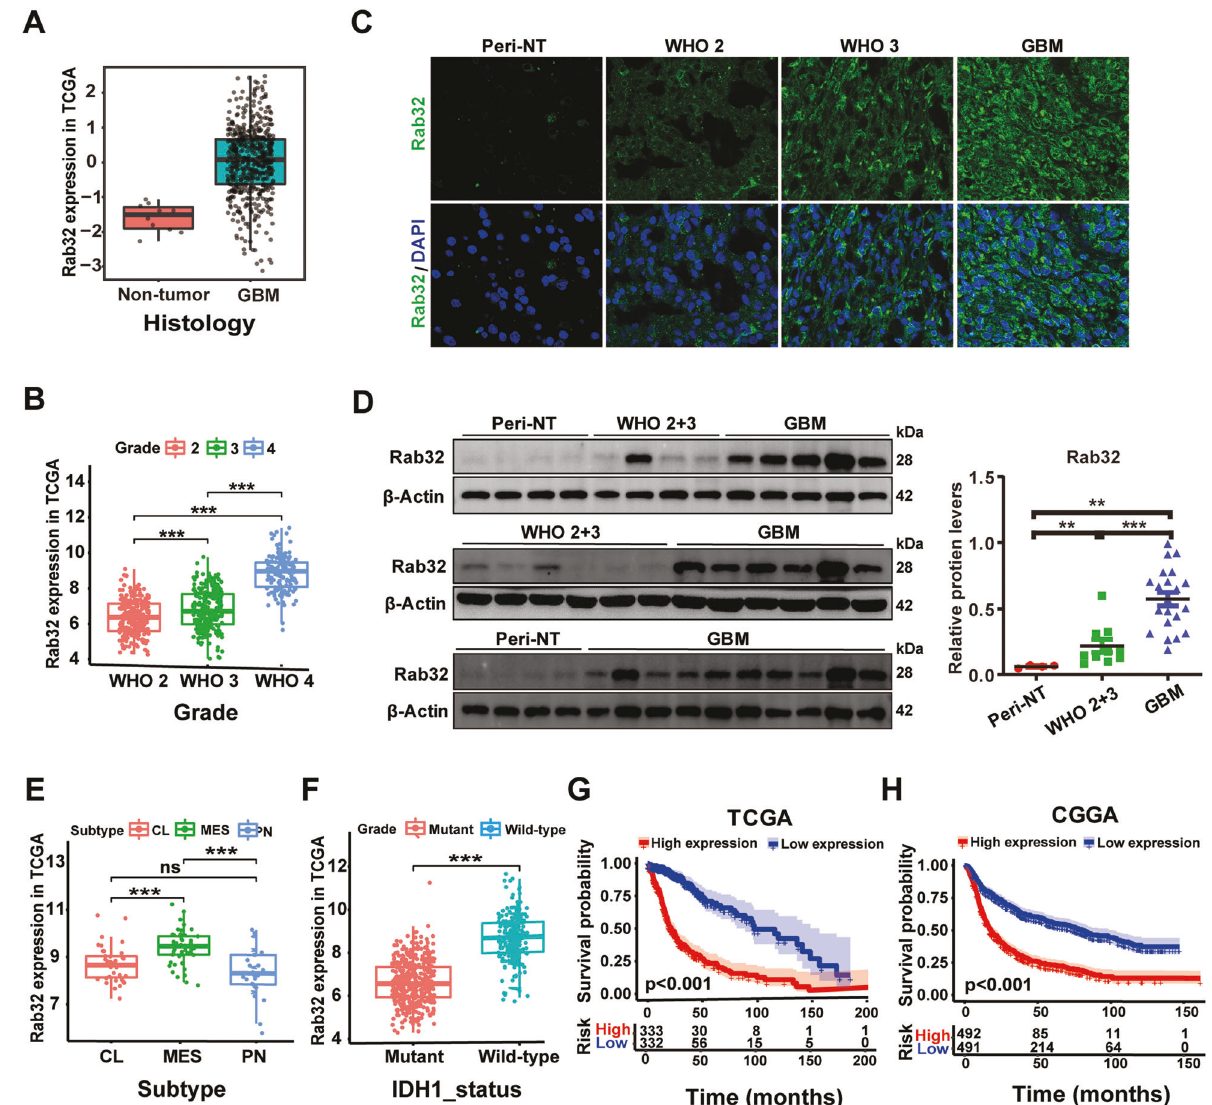
TCGA database. C Representative immuno fl uorescent staining of Rab32 expression in clinical glioma tissue and normal peritumor tissues. Scale bar = 50 μ m. D Western blot analysis of Rab32 protein level in human glioma patient samples grade 2 ( n = 4), grade 3 ( n = 6), grade 4 ( n = 21) and normal peritumor brain tissues ( n = 4). β -Actin was used as a loading control. All data are shown as the mean ± SD (at least three independent experiments). * P < 0.05, ** P < 0.01, *** P < 0.001. E , F The expression features of Rab32 in glioma of different molecular phenotype and IDH-status in TCGA database. G , H Kaplan – Meier analysis for correlation between Rab32 mRNA expression and survival of patients with gliomas in the TCGA and CGGA